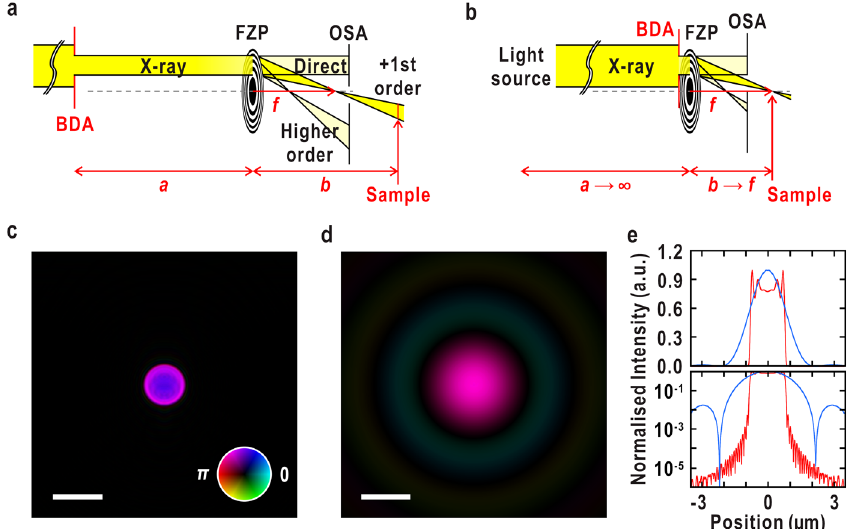
Fig. 2 Schematic con fi guration and numerical simulation results of coherent illumination optics. a Projection illumination optics proposed in this study. b Conventional focusing optics in off-axis con fi guration. BDA beam-de fi ning aperture, FZP Fresnel zone plate, OSA order-sorting aperture. c , d Calculated wave fi eld of each optics con fi guration at the sample plane. Brightness and hue represent the amplitude and phase distributions of the waves, as shown in the inset in c . The inclination of the wavefront was corrected, as shown in Supplementary Fig. 1. Scale bars indicate 2 μ m. e Horizontal intensity pro fi le of wave fi eld c in red and d in blue, respectively. Each pro fi le is normalised with its maximum intensity, and the wave fi eld ( c ) was 2.4-times higher than that of ( d ). Upper graph is drawn in linear scale, and the lower is drawn in logarithmic scale.